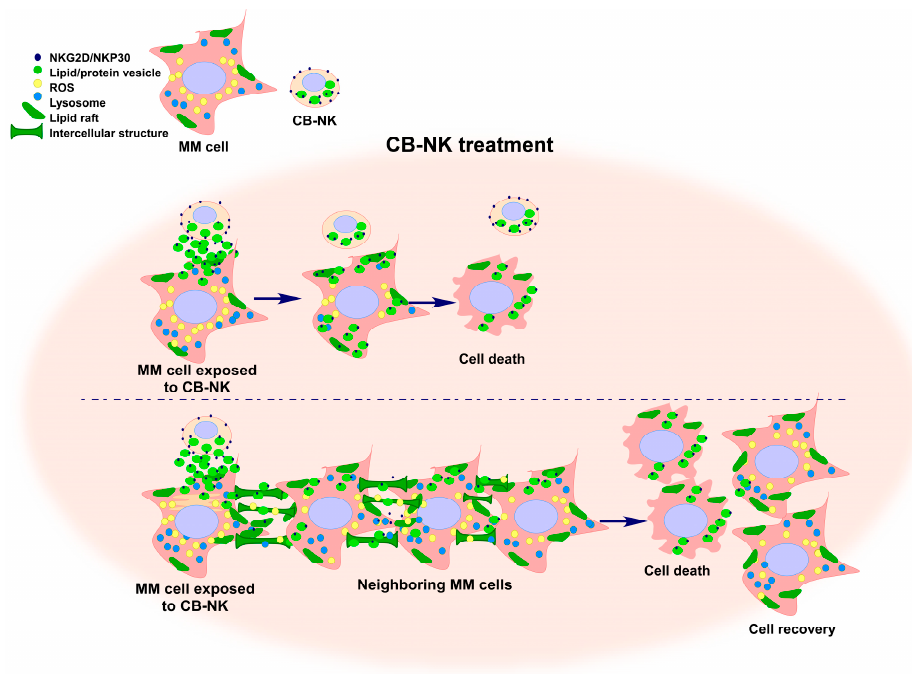
Figure 2. Transmissible cytotoxicity mediated by cord blood-derived NK cells (CB-NK) against multiple myeloma (MM) cells. When MM cells and CB-NK become in contact, NKG2D and NKP30 receptors are transferred into MM cells through lipid structures. A decrease in reactive oxygen species (ROS) and lysosome (Lys) levels is observed in MM cells exposed to CB-NK. When neighboring MM cells contact MM cells exposed to CB-NK, NK cell receptors are transferred into these neighboring MM cells, and Lys and ROS levels also decrease into neighboring MM cells. Consequently, a fraction of neighboring MM cells dies because of this CB-NK cytotoxicity. At the same time, ROS and Lys levels in MM cells exposed to CB-NK return to their original levels which could be a recovery of the initial damage caused by CB-NK.